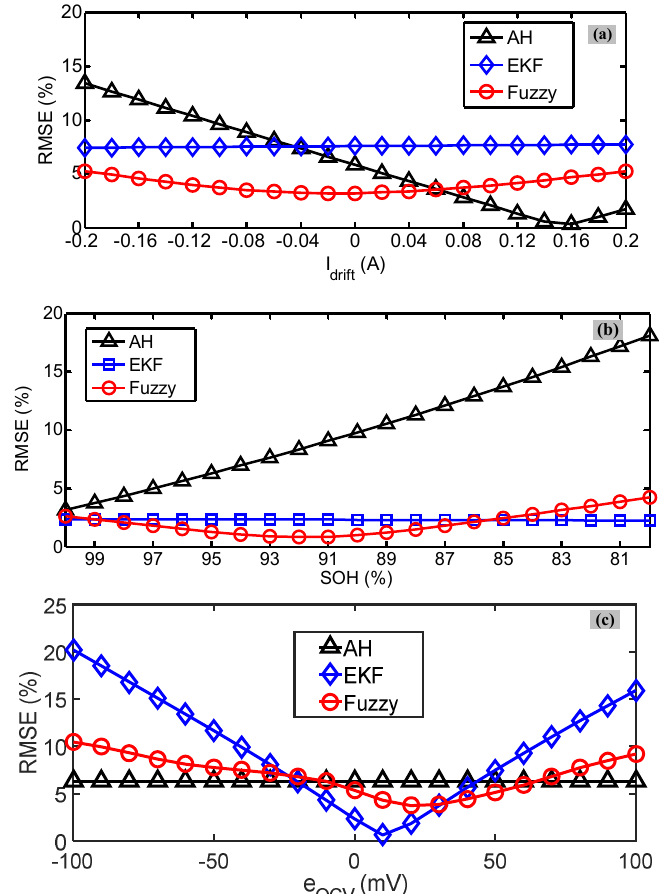
Figure 15. RMSE of SOC for cases D, E, and F. ( a ) Case D: RMSE of SOC in different drift currents; ( b ) case E: RMSE of SOC in different SOHs; and ( c ) Case F: RMSE of SOC in different SOC–OCV curve errors.